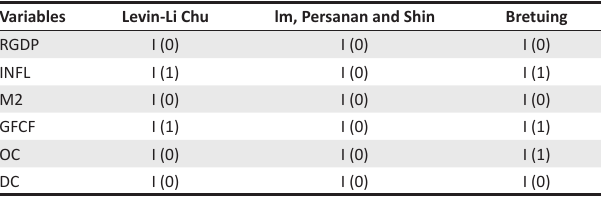
RGDP, real GDP; INFL, inflation; GFCF, gross fixed capital formation; DC, domestic credit; OC, openness of a country. TABLE 3: Correlation matrix of vector explanatory variables Variable